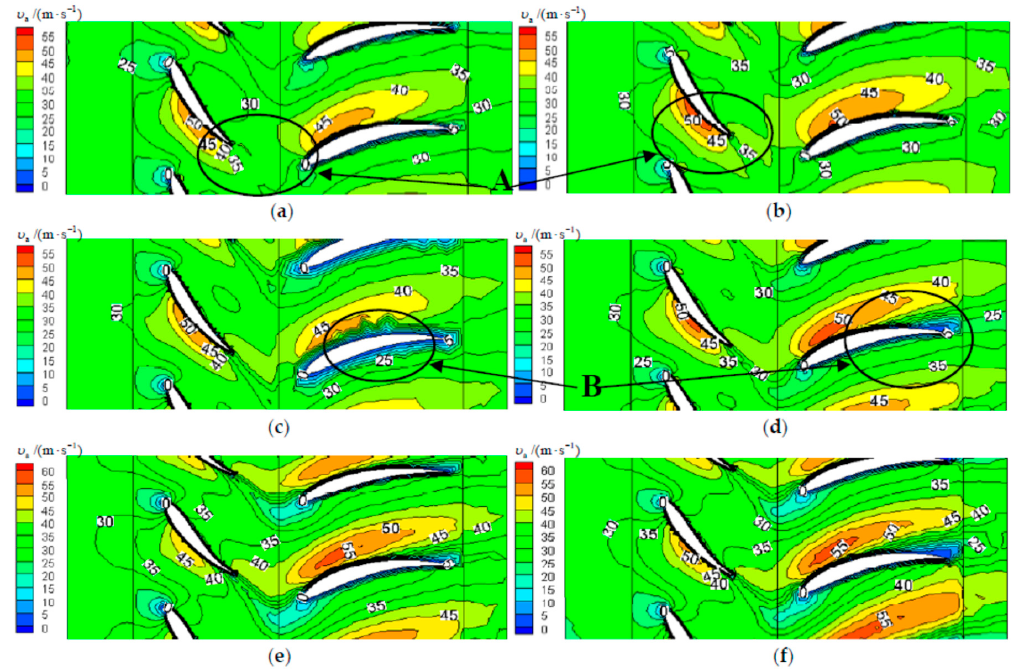
Figure 9. Distribution of the axial velocity at the section of R = 0.5. ( a ) β = 29 ◦ , θ = 0 ◦ ; ( b ) β = 29 ◦ , θ = 3.0 ◦ ; ( c ) β = 32 ◦ , θ = 0 ◦ ; ( d ) β = 32 ◦ , θ = 3.0 ◦ ; ( e ) β = 35 ◦ , θ = 0 ◦ ; ( f ) β = 35 ◦ , θ = 3.0 ◦ .